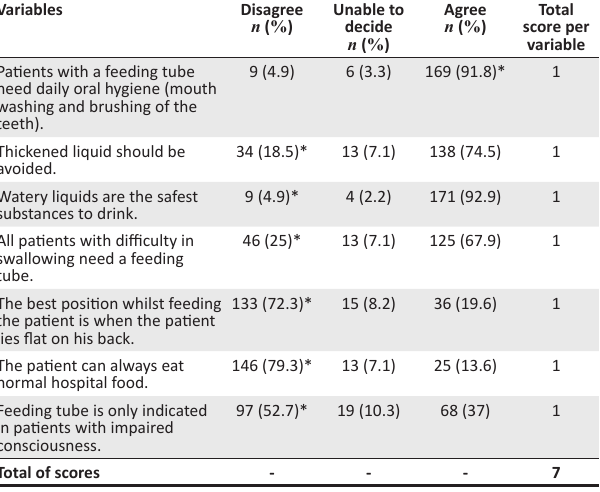
TABLE 4: Participants’ responses on their knowledge of management ( n = 184). Variables Patients with a feeding tube need daily oral hygiene (mouth washing and brushing of the teeth).